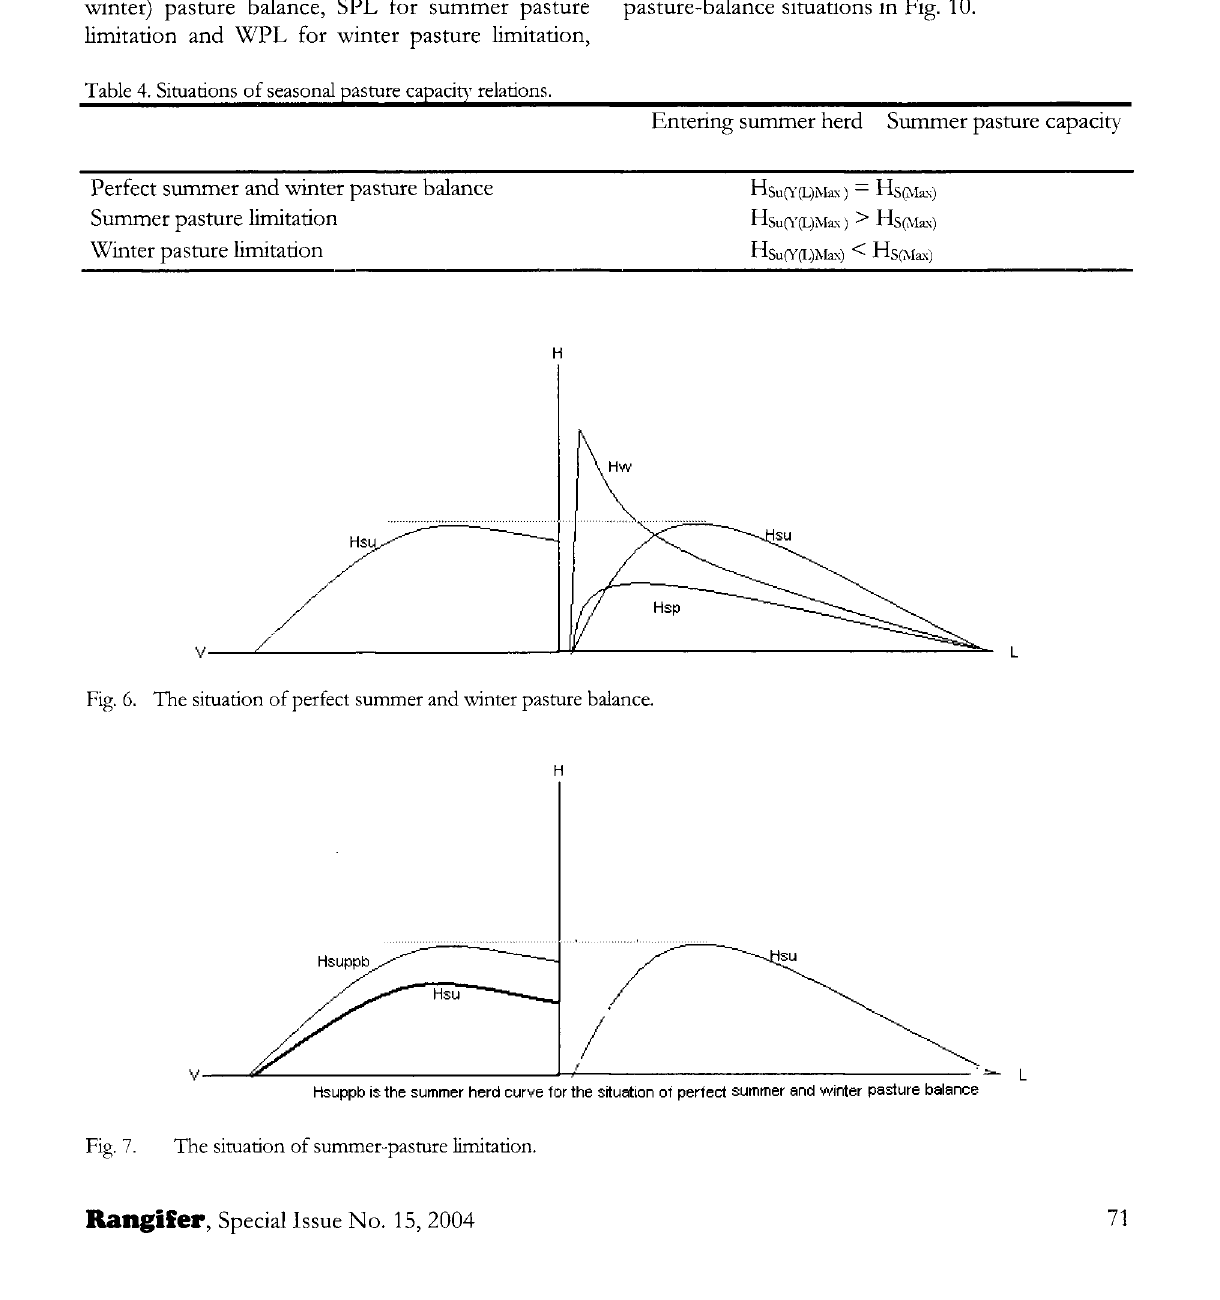
Fig. 7. The situation of summer-pasture